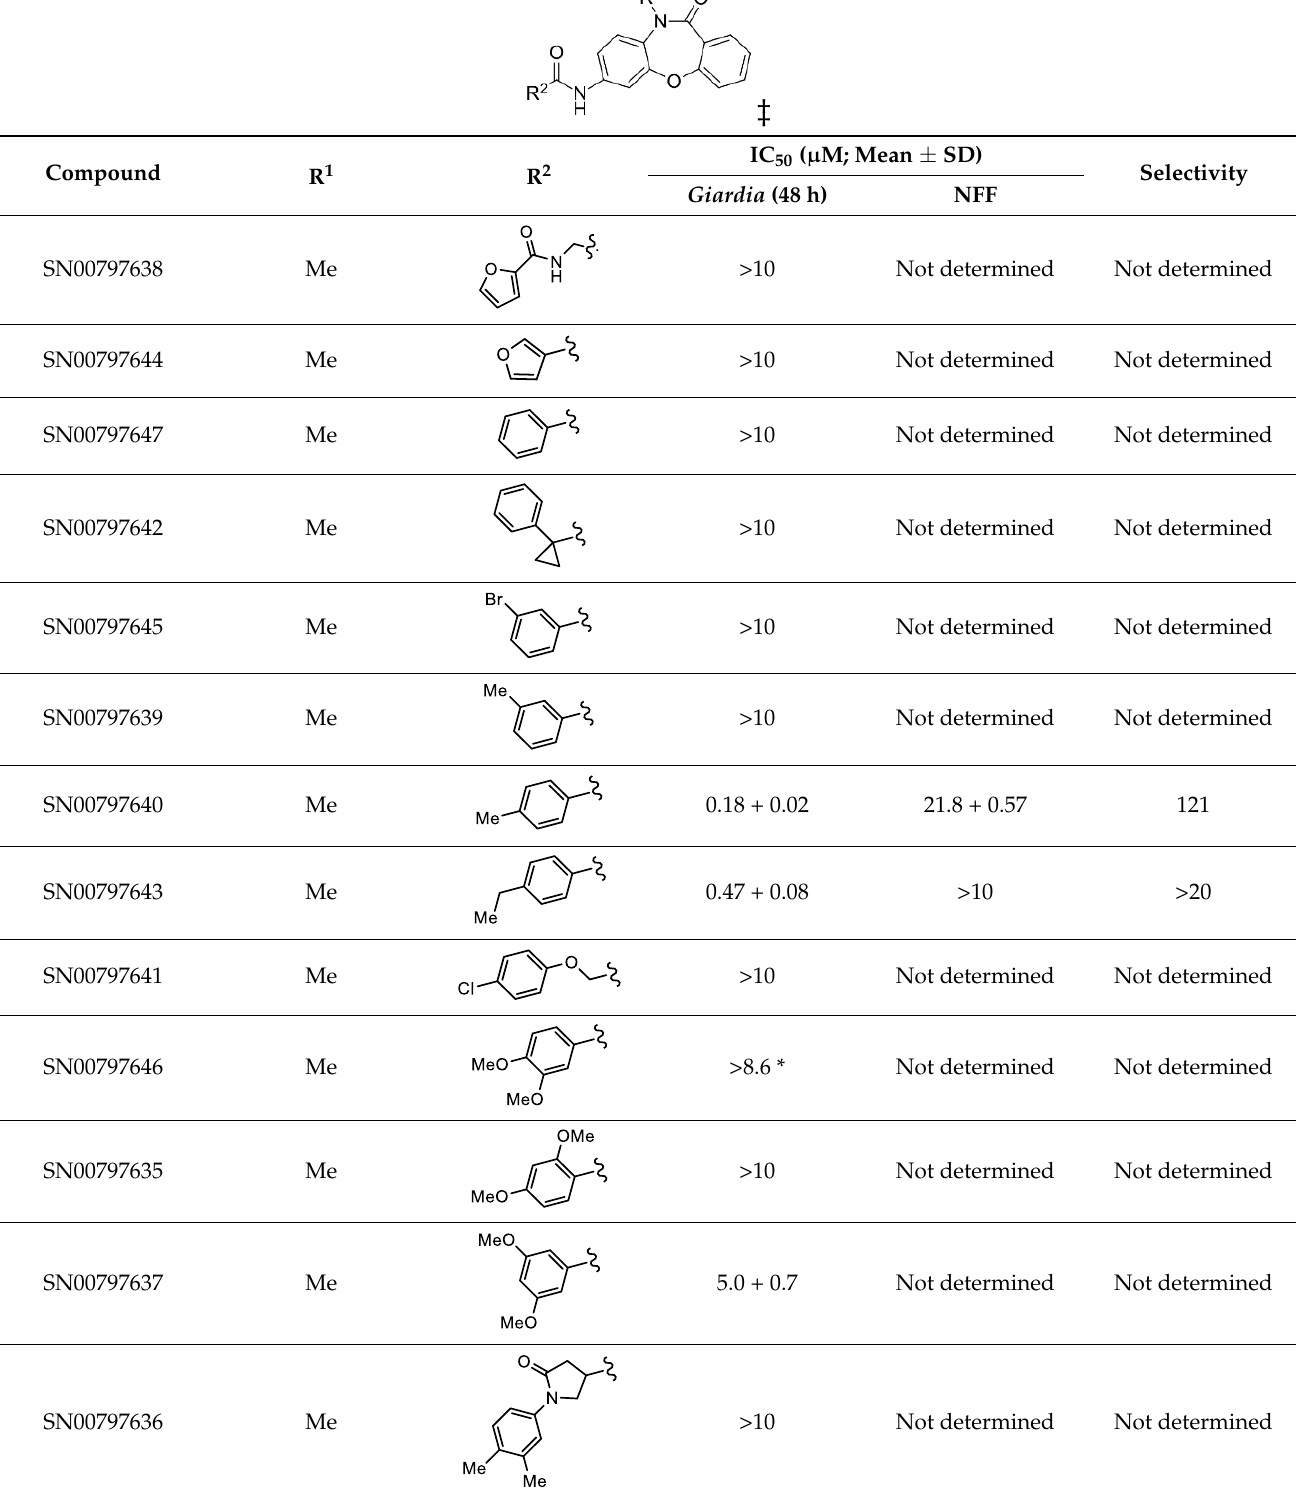
Table 2. The in vitro activity of compounds in the CL9406 scaffold set.